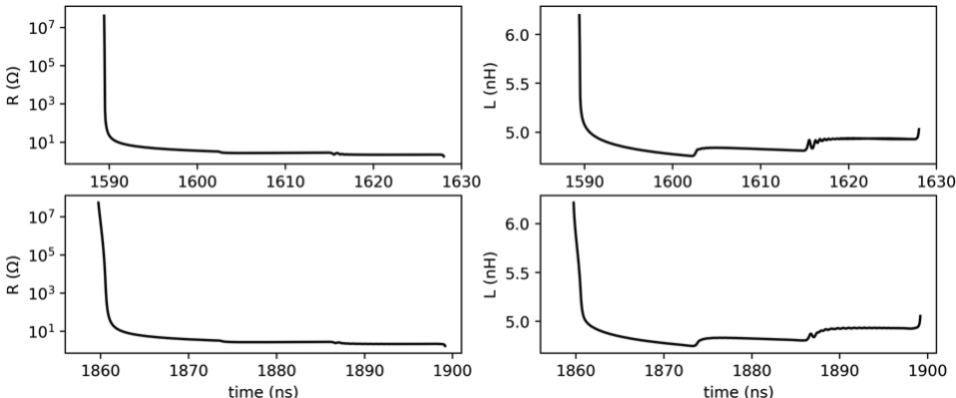
Figure 7. The nonlinear resistance (logarithmic scale) and inductance (linear scale) values of the arc channel during the pulse time depicted in Figure 5.